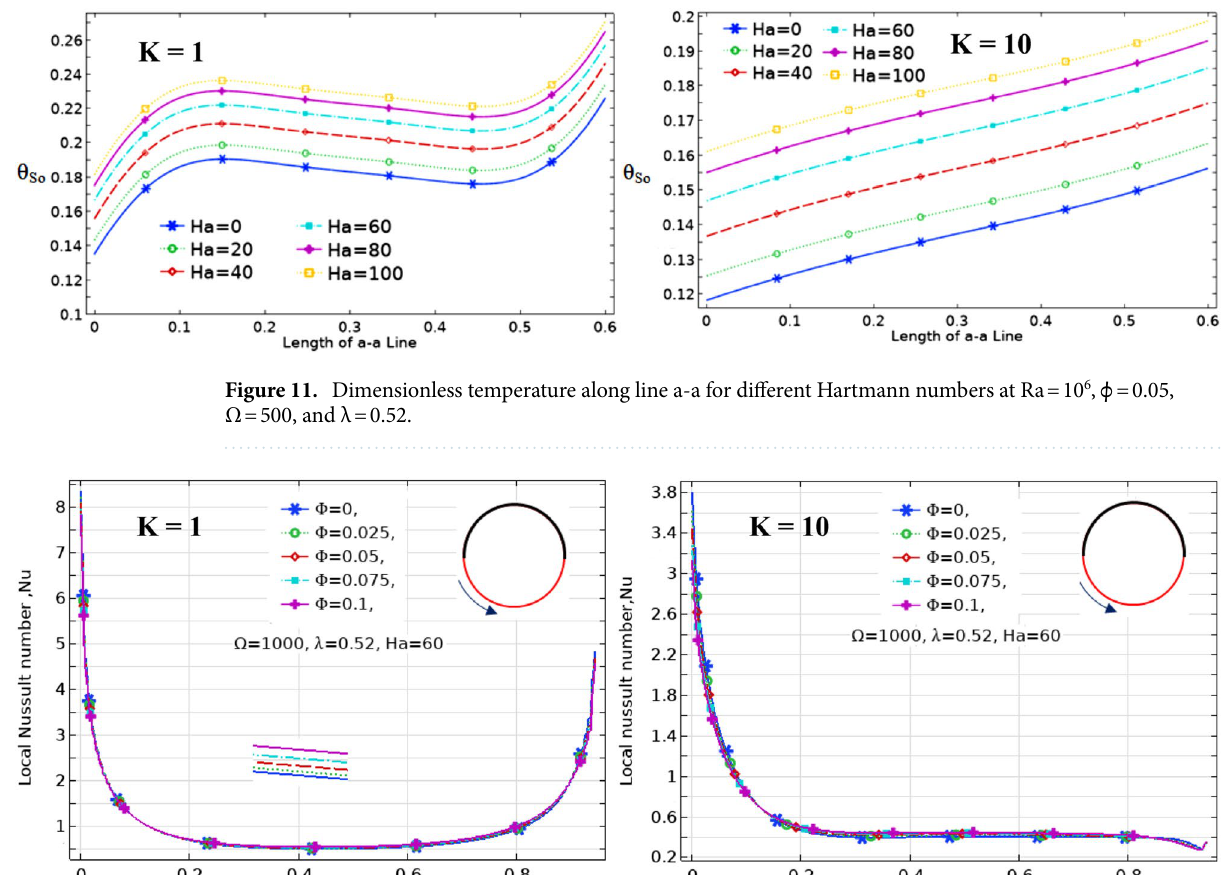
Figure 12. Local Nusselt number along contact arc for different NPs volume fractions at Ra = 10 6 , Ha = 60, Ω = 1000, and λ = 0.52.